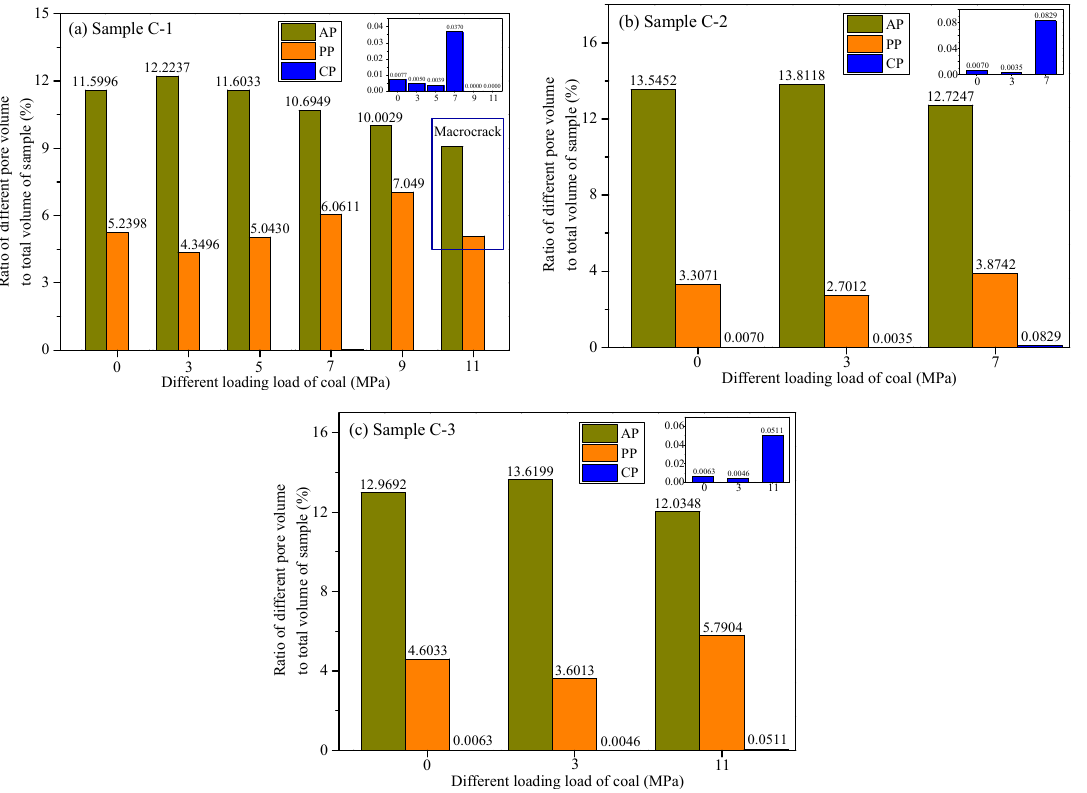
Figure 9. Evolution law of different pores and fissures of Group C coal samples under progressive load: ( a ) Sample C-1, ( b ) Sample C-2, ( c ) Sample C-3.